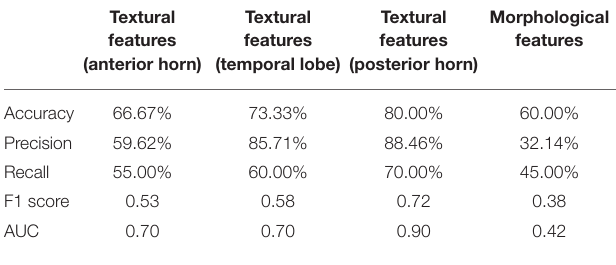
TABLE 3 | Performance of models based on textural features and morphological features. Textural features